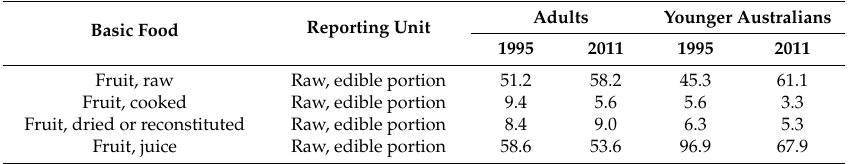
Table 2. Reported intake of fruit (kg/person/year) by adult (19 years and above) and younger Australians (2 to 18 years) in 1995 and 2011. 1